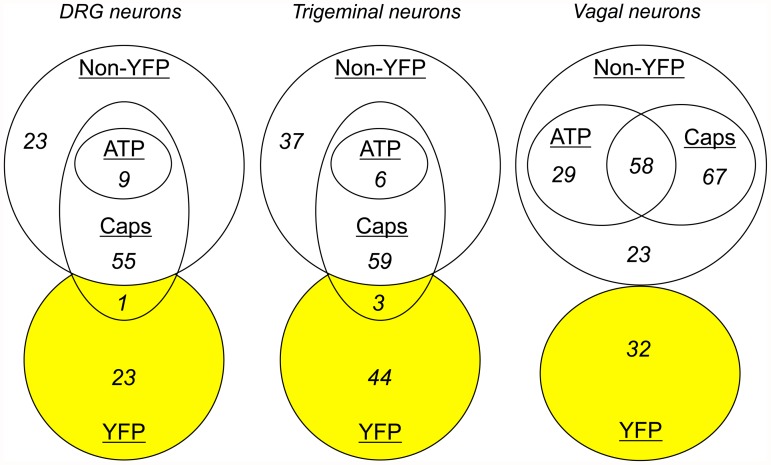
Euler diagrams comparing sensory nerve populations with YFP expression.Populations ascribed by sensitivity to α,β methylene ATP (10 μM) and capsaicin (Caps, 1 μM,).